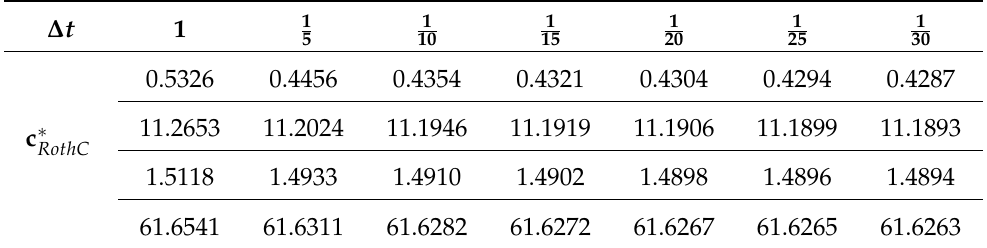
Table 1. Dependence of the steady-state solution of the discrete RothC model on the temporal stepsize ∆ t . The values in each compartment converge, with first-order accuracy, to the entries of = [ 0.4254, 11.1867, 1.4887, 61.6253 ] T c ∗ cont